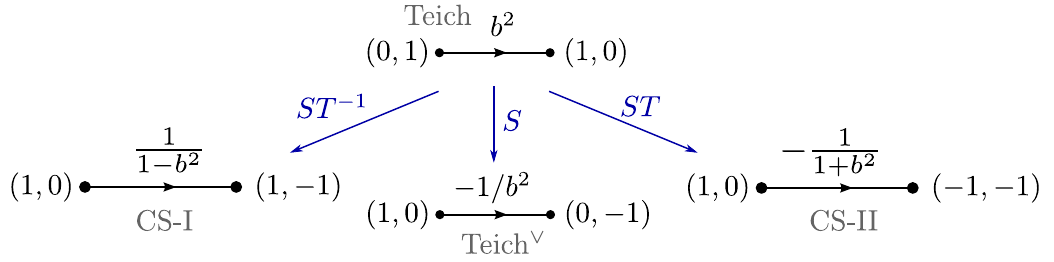
Figure 7 . Brane construction for Teichm(cid:127)uller TQFT, and its duals. For each con(cid:12)guration, we show the boundary condition types ( p; q ) and the value of the canonical parameter K . Blue arrows are the S-duality